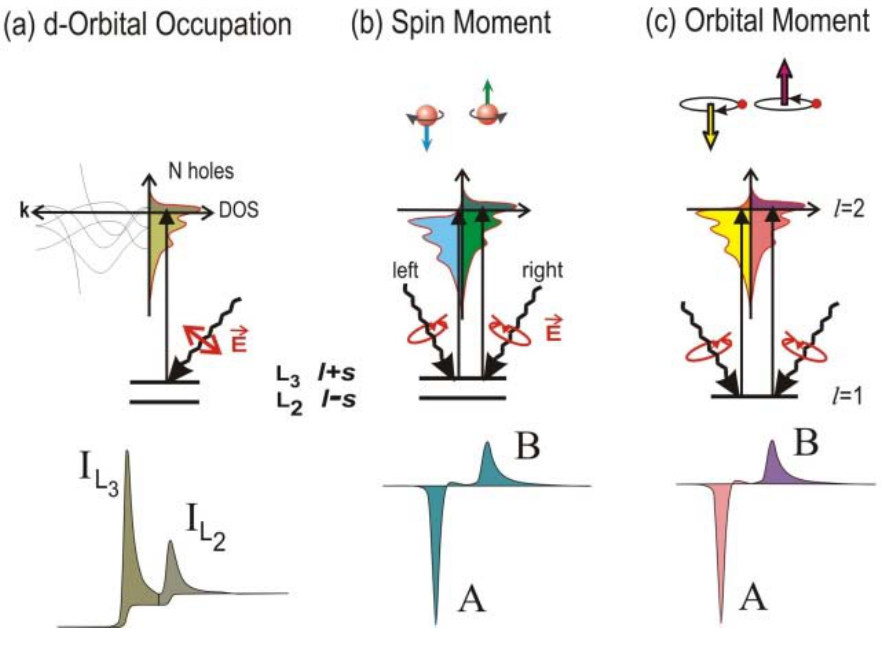
FIGURE 14 . Scheme of the principles of XMCD. From ref. [112]. Reproduced with permission of the